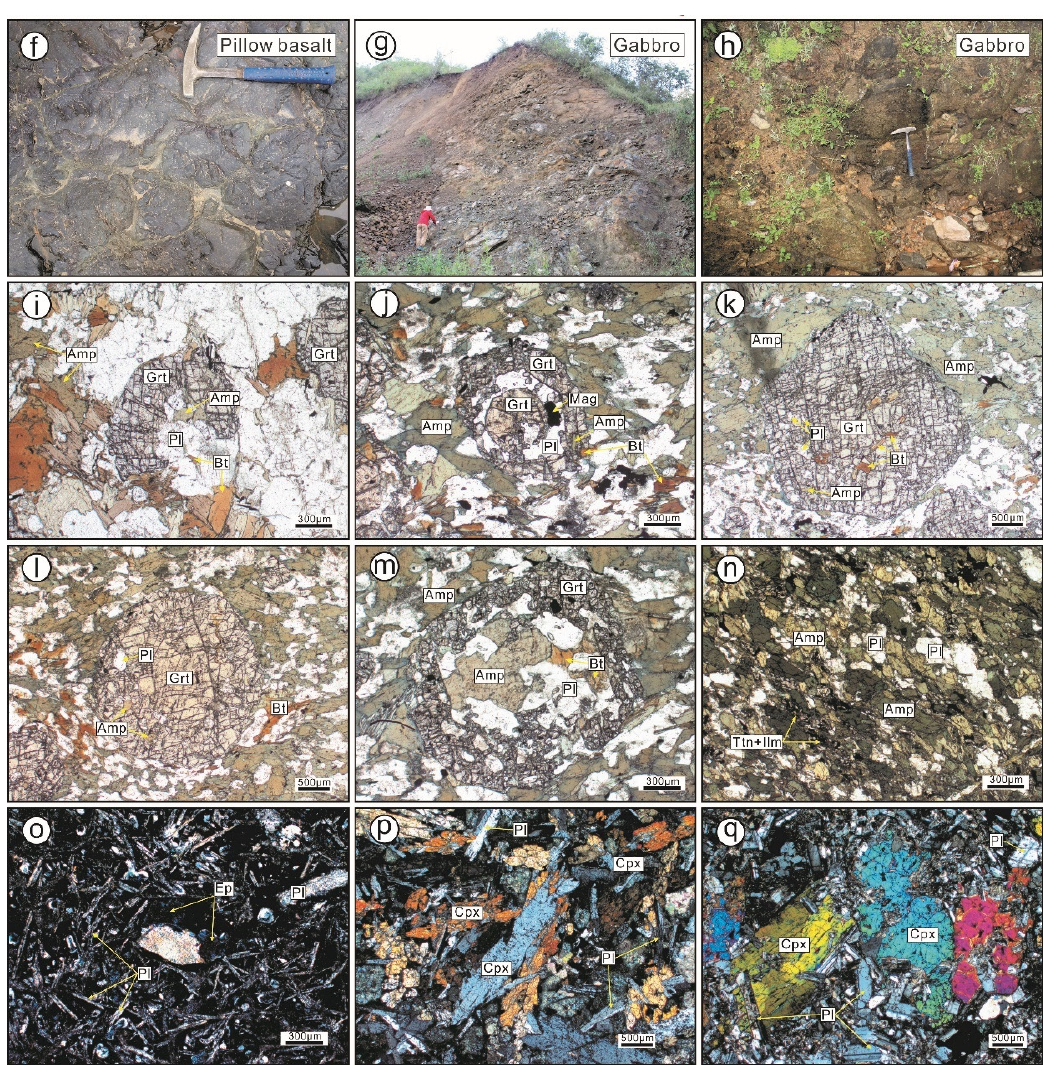
Figure 2. ( a – h ) Field photographs and ( i – q ) photomicrographs of mafic and metamafic rocks in the JASB. ( a ) Amphibolite in the Batang area; ( b ) Bedded Grt-bearing amphibolite in the Batang area; ( c ) Amphibolite intruded by felsic vein in the Batang area; ( d ) Amphibolite is accompanied by serpentinite and in contact with Bt-Ms schist by the fault in the Batang area; ( e ) Amphibolite is in sharp contact with Bt-Ms schist by the fault in the Batang area; ( f ) Pillow basalt in the Yaxuanqiao area; ( g ) Massive gabbro in the Yaxuanqiao area; ( h ) Gabbro in the Lvchun area; ( i ) Garnet in Grt-Bt amphibolite alternating with amphibole, plagioclase, and biotite; ( j ) Multiple atoll microstructures of garnet in Grt-Bt amphibolite with BSE image; ( k , l ) Euhedral and subhedral garnet in Grt-Bt amphibolite with inclusions of plagioclase, biotite, and amphibole in core and rim, respectively; ( m ) Euhedral atoll garnet in Grt-Bt amphibolite; ( n ) Dark green amphibolite with oriented amphibole and plagioclase; ( o ) Basalt with altered clinopyroxene phenocryst in the Yaxuanqiao area; ( p ) Fresh gabbro in the Yaxuanqiao area; ( q ) Porphyritic gabbro in the Lvchun area. The basalt shows a porphyritic texture (Figure 2o). Most phenocrysts are coarse chlorogenic clinopyroxenes, and the matrix is mainly plagioclase and fine chlorogenic clinopyroxenes. The gabbro from the Yaxuanqiao area is largely composed of euhedral to subhedral coarse clinopyroxene (40%–45%) and plagioclase (50%–55%). Clinopyroxene is partly altered to chlorite along fractures and plagioclase to microcrystalline epidote (Figure 2p). The gabbro from the Lvchun area shows porphyroid texture, and it consists of clinopyroxene phenocrysts (50%–60%), fine plagioclase matrix (35%–40%), and minor magnetite (<5%) (Figure